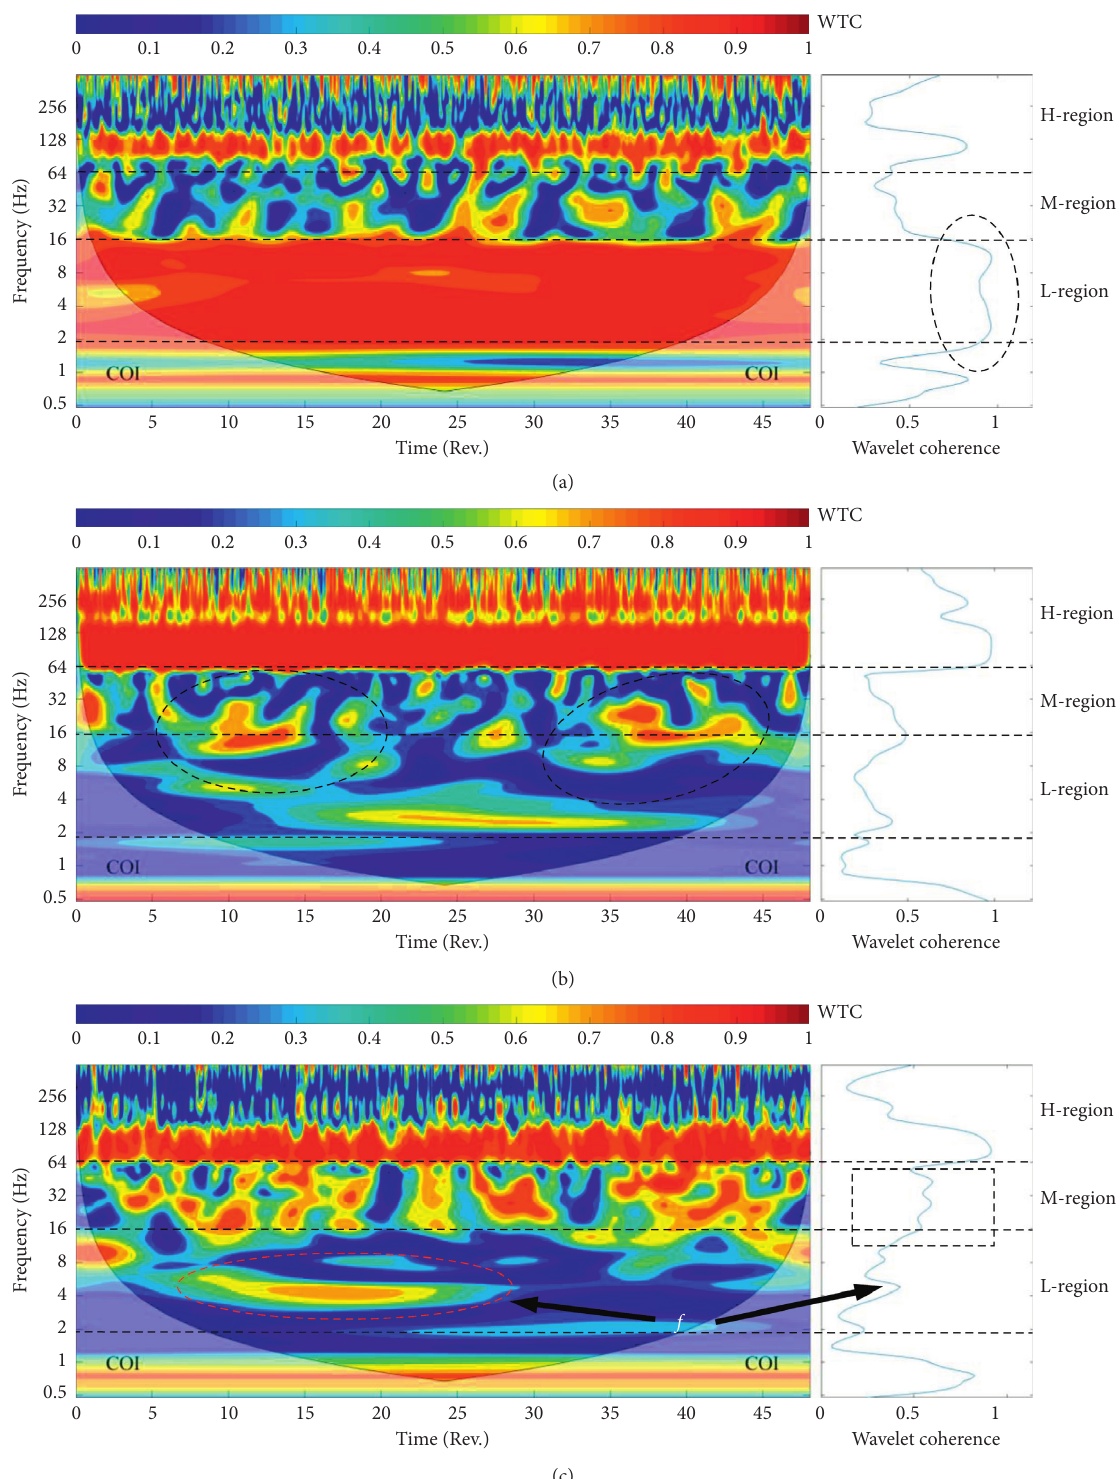
Figure 10: Wavelet coherence spectrum of pressure pulsation of adjacent pressure sensors with different tip clearances. (a) Impeller inlet. (b) Impeller middle. (c) Impeller